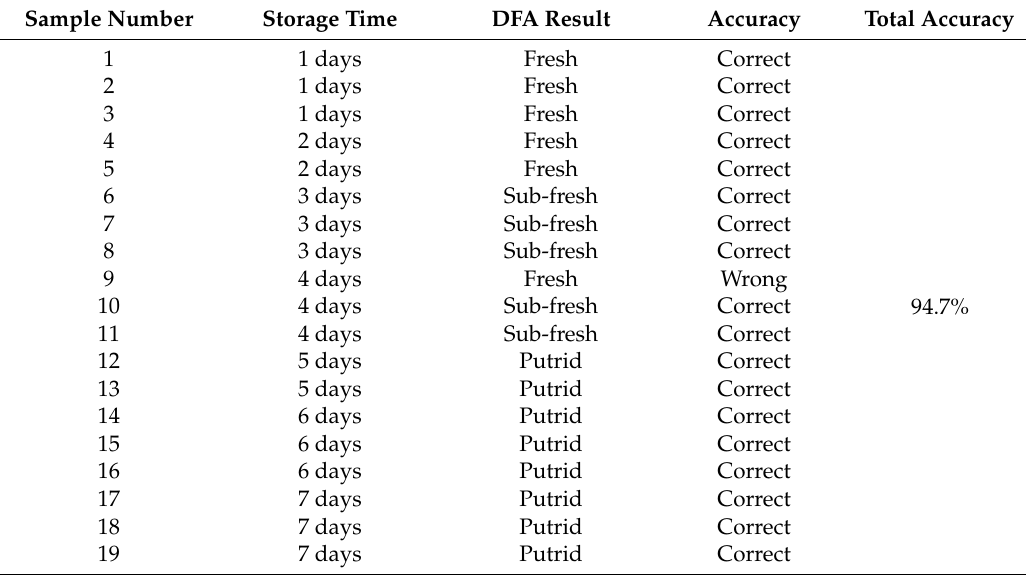
Figure 6. The results of mutton samples with different storage times for 7 days: ( a ) PCA result; ( b ) DFA result and ( c ) Loading plot figure. Table 5. DFA results of the 19 unknown mutton